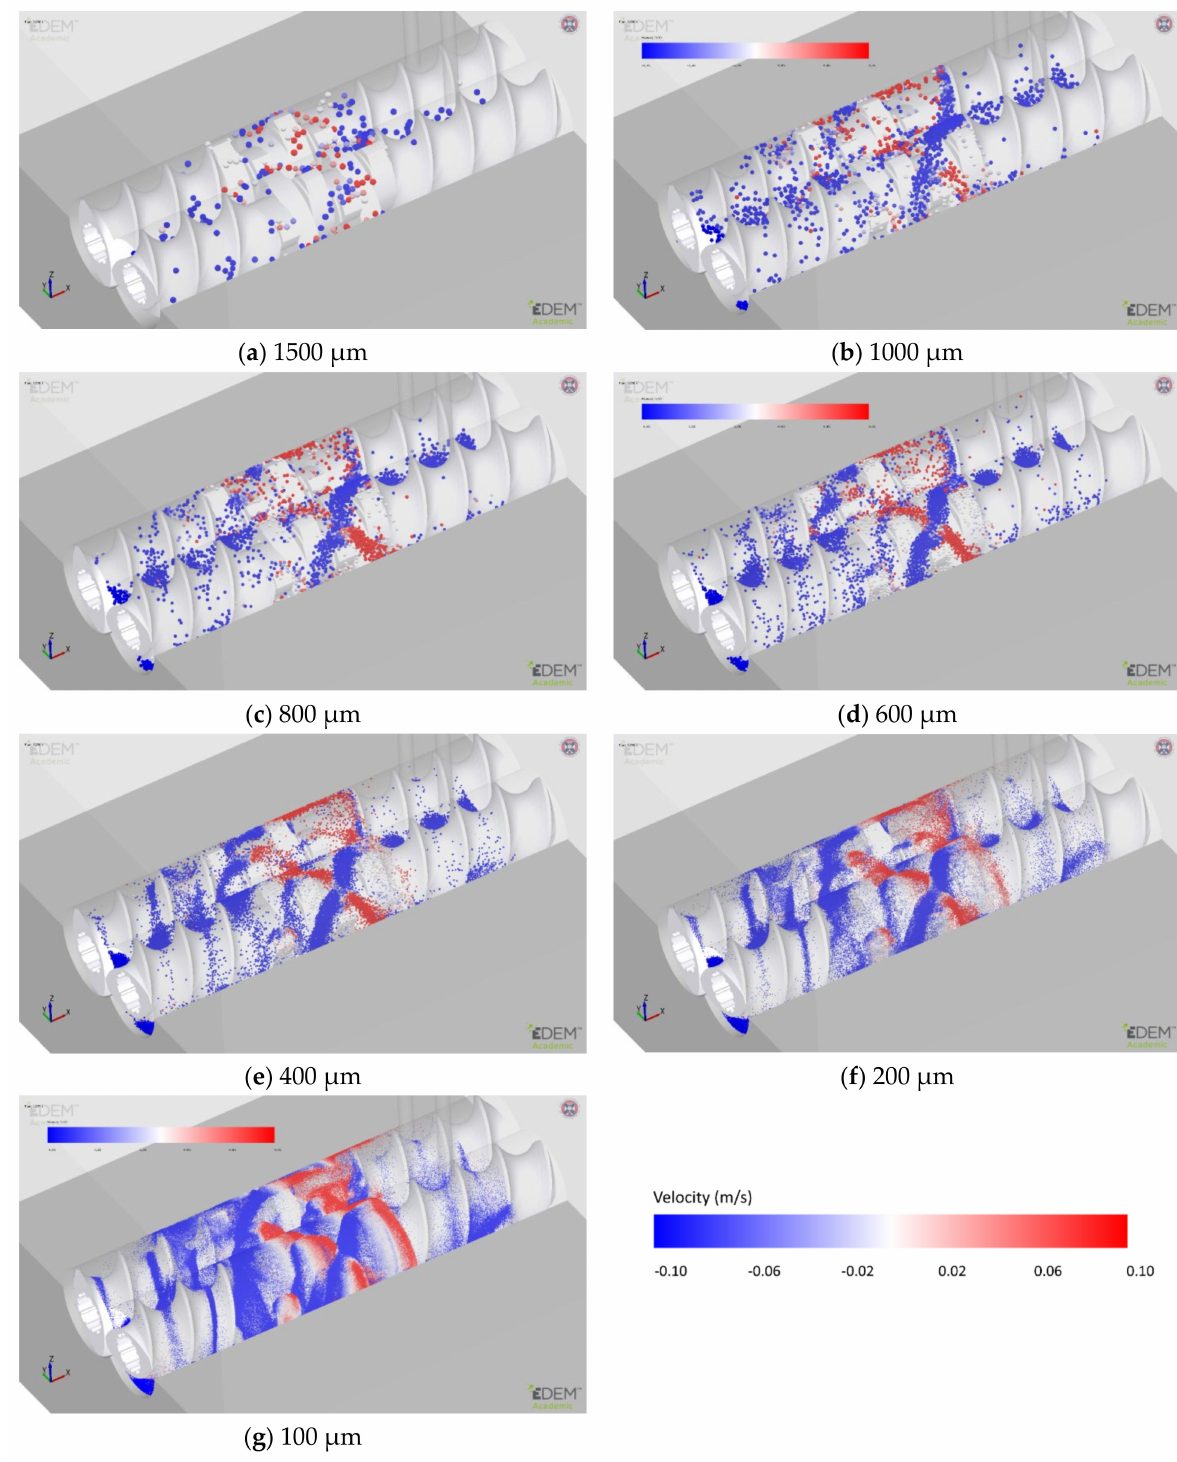
Figure 11. Particle snapshots at steady state as the mean particle diameter is varied. The particle colour indicates longitudinal velocity in the direction parallel to the screws; a negative velocity indicates the movement of particles towards the outlet of the